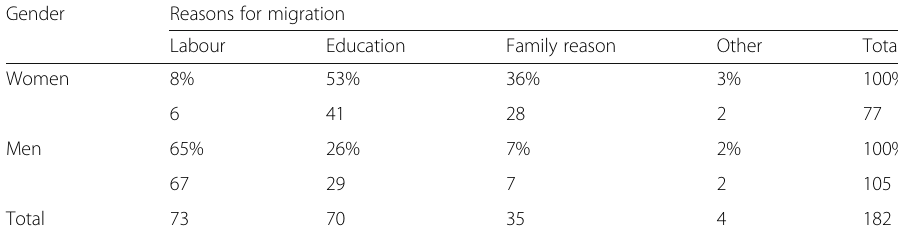
Table 2 Migrants according to their mobility motivations Gender Reasons for